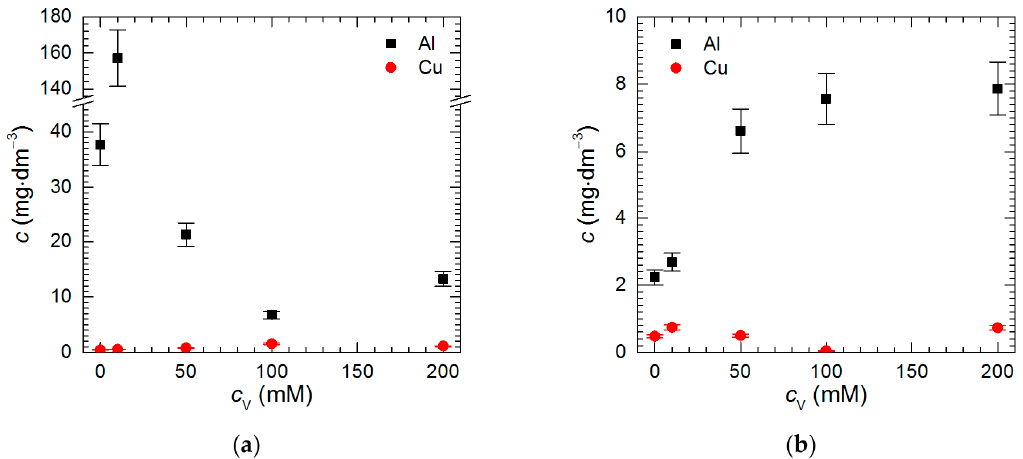
Figure 3. Concentration of Cu and Al in H 2 SO 4 solutions after t = 576 min immersion of intermetallic Al 2 Cu, T = 303 K as a function of the initial concentration of Na 3 VO 4 : ( a ) pH = 1.3; ( b ) pH = 2.5.